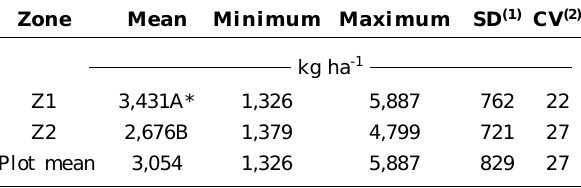
(1) SD: standard deviation; (2) CV: coefficient of variation. *Means followed by different letters indicate significant difference (p<0.05) by Student’s